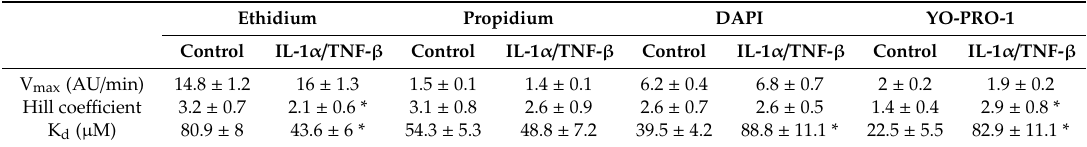
Table 1. Permeability parameters of astroglial Cx43 hemichannels. Ethidium Propidium DAPI YO-PRO-1 Control IL-1 α / TNF- β Control IL-1 α / TNF- β